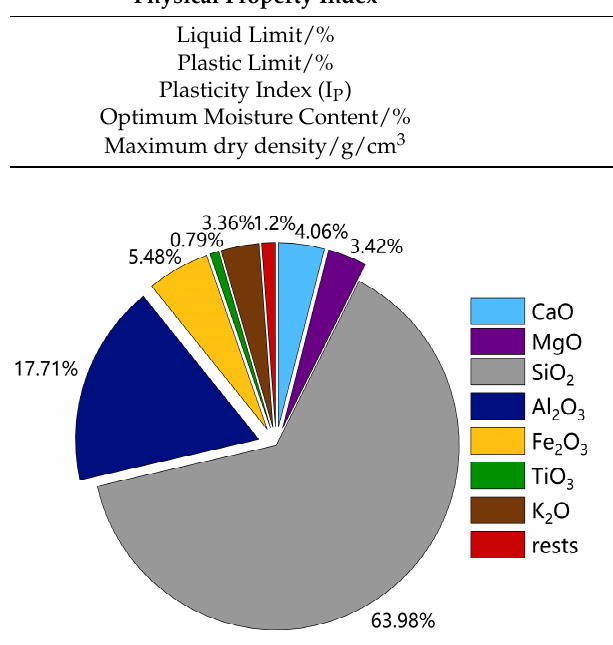
Figure 1. Main chemical components of undisturbed soil.